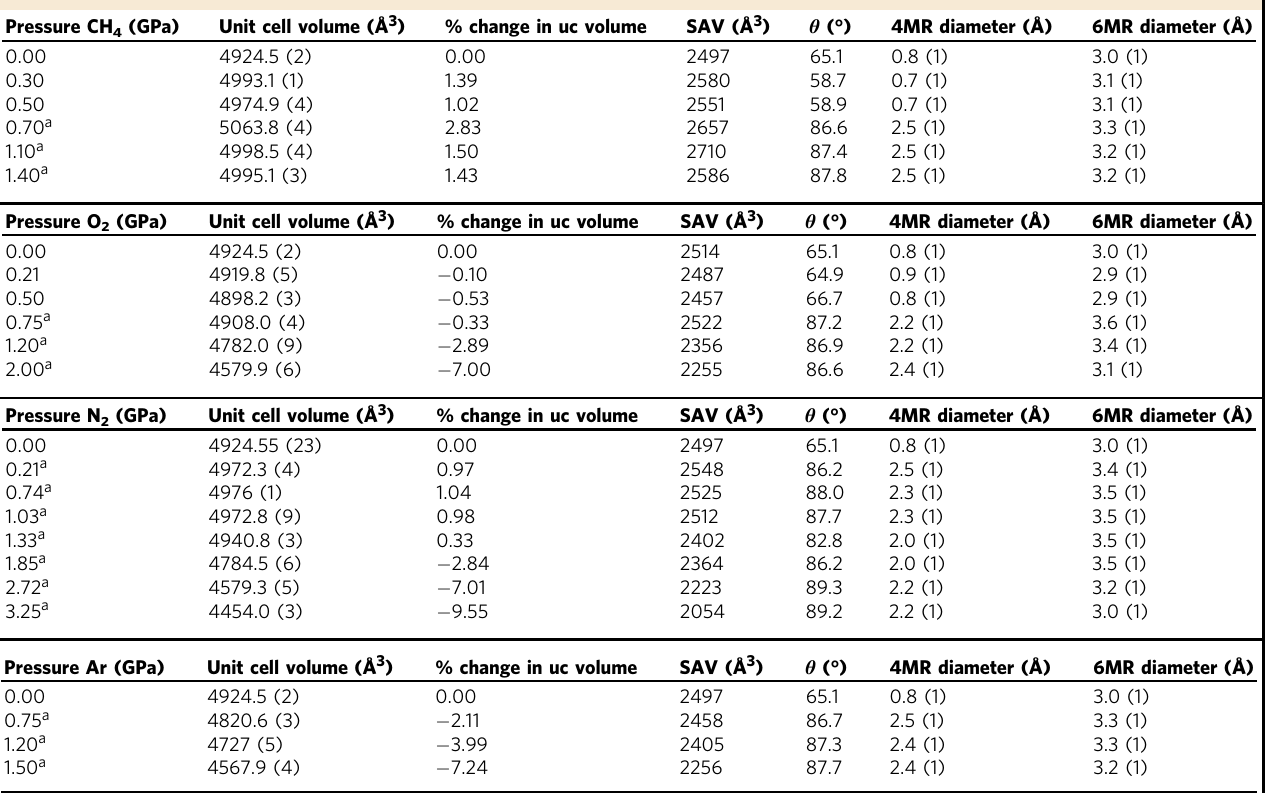
Diameters of 4MR and 6MR calculated using the void analysis routine in Mercury, (grid spacing of 0.2Å) 14 SAV solvent accessible volume, calculated using PLATON 37 a The ZIF-8-HP